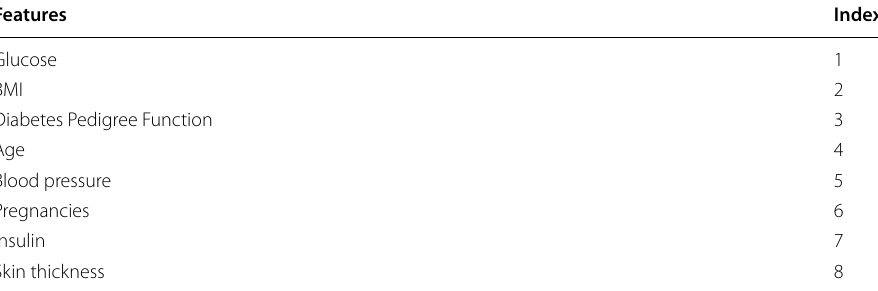
Table 7 Relevant feature predicted by random forest